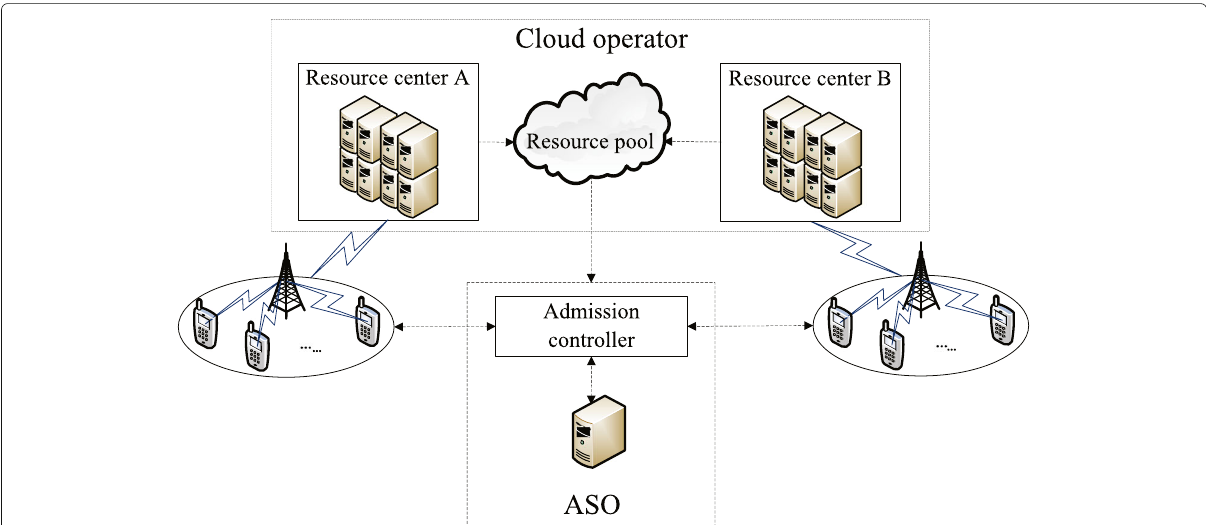
Fig. 1 Mobile cloud computing system architecture. The MCC system architecture is divided into 3 parts, including the mobile users, the ASO, and the cloud operator